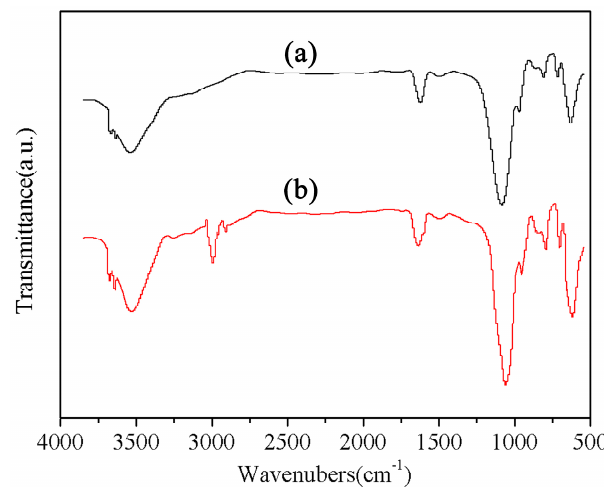
Figure 1. FTIR spectra of ( a ) unmodified red pottery clay (RPC) and ( b ) modified RPC (mRPC).